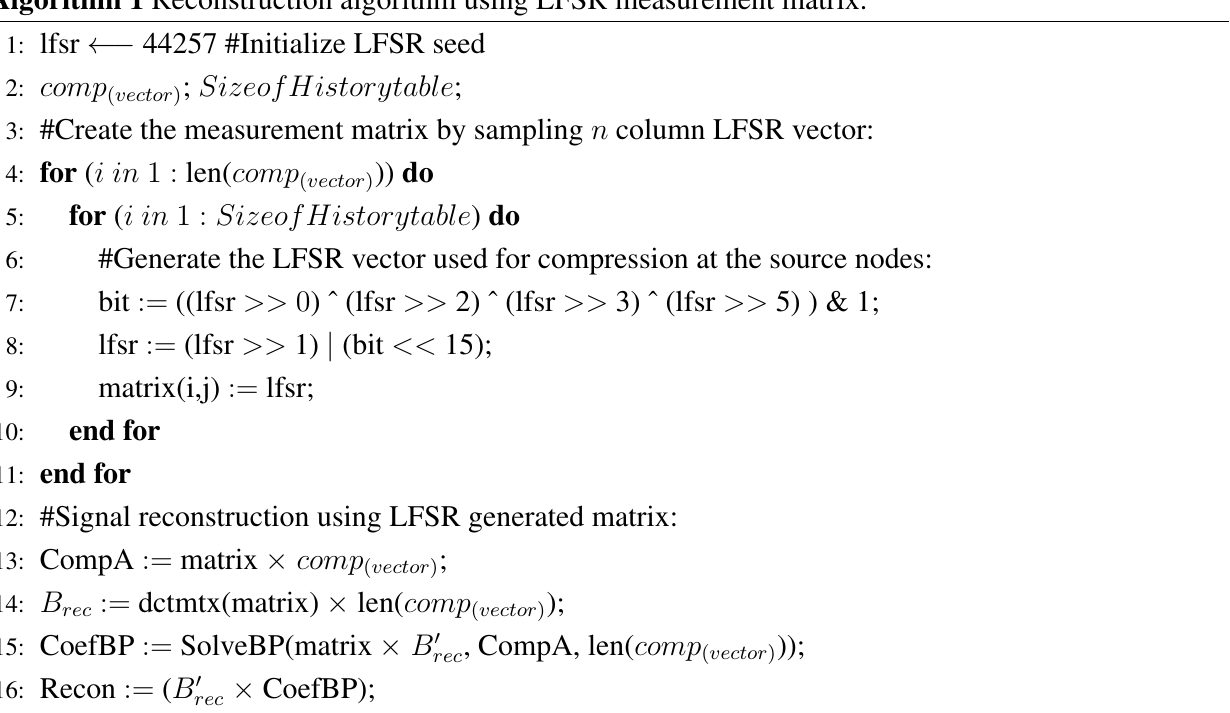
Algorithm 1 Reconstruction algorithm using LFSR measurement